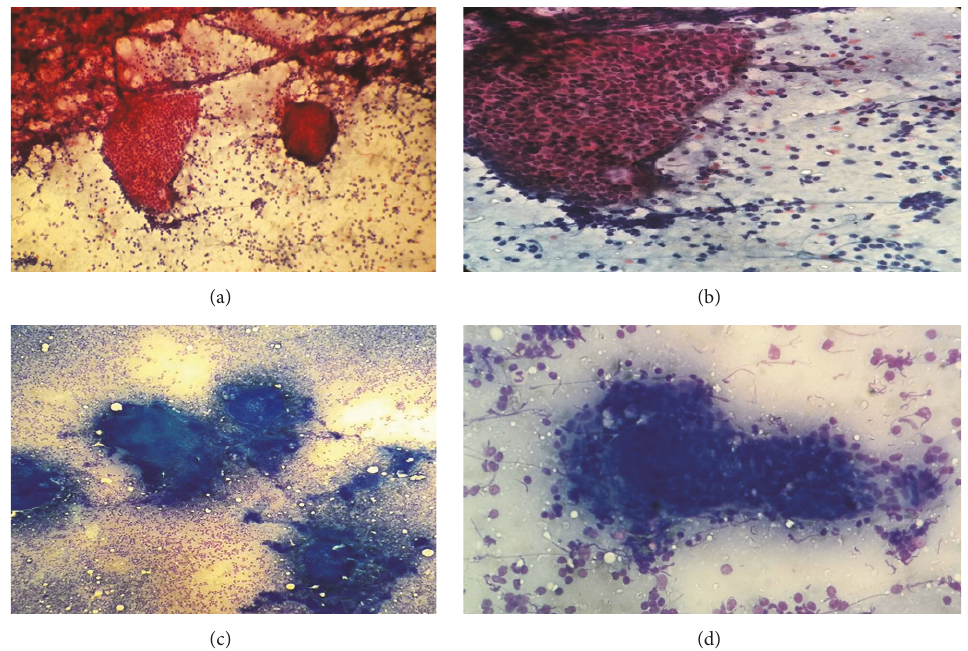
Figure 2: (a) & (b) low and high power view of aspirated material showing mixture of variably sized lymphocytes with few clusters of ductal epithelial cells ((a) × 10 and (b) × 40 papanicolaou stain). (c) & (d) low and high power view of the same material showing lymphocytic background with some dense proteinaceous material and ductal epithelial clusters ((a) × 10 and (b) × 40 wright